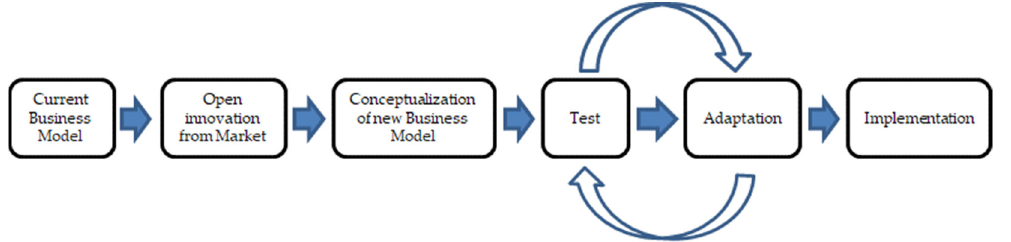
Figure 1. Business model innovation process. Source: adapted by M. Peñarroy-Farell and F. Mi- ralles [70] form H. Chesbrough and R.S. Rosenbloom [12].